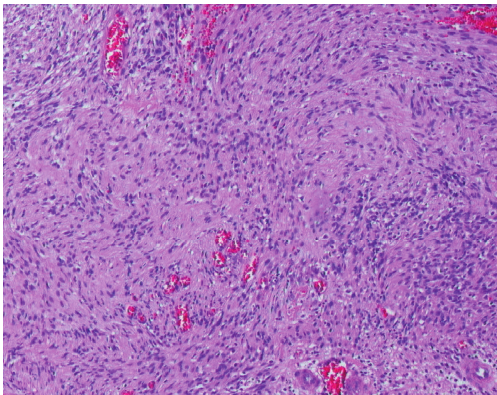
Figure 5: Histopathological examination showing high cellular density and a palisading pattern of the tumor cells ( × 40 power, H&E-stained microscopic slide